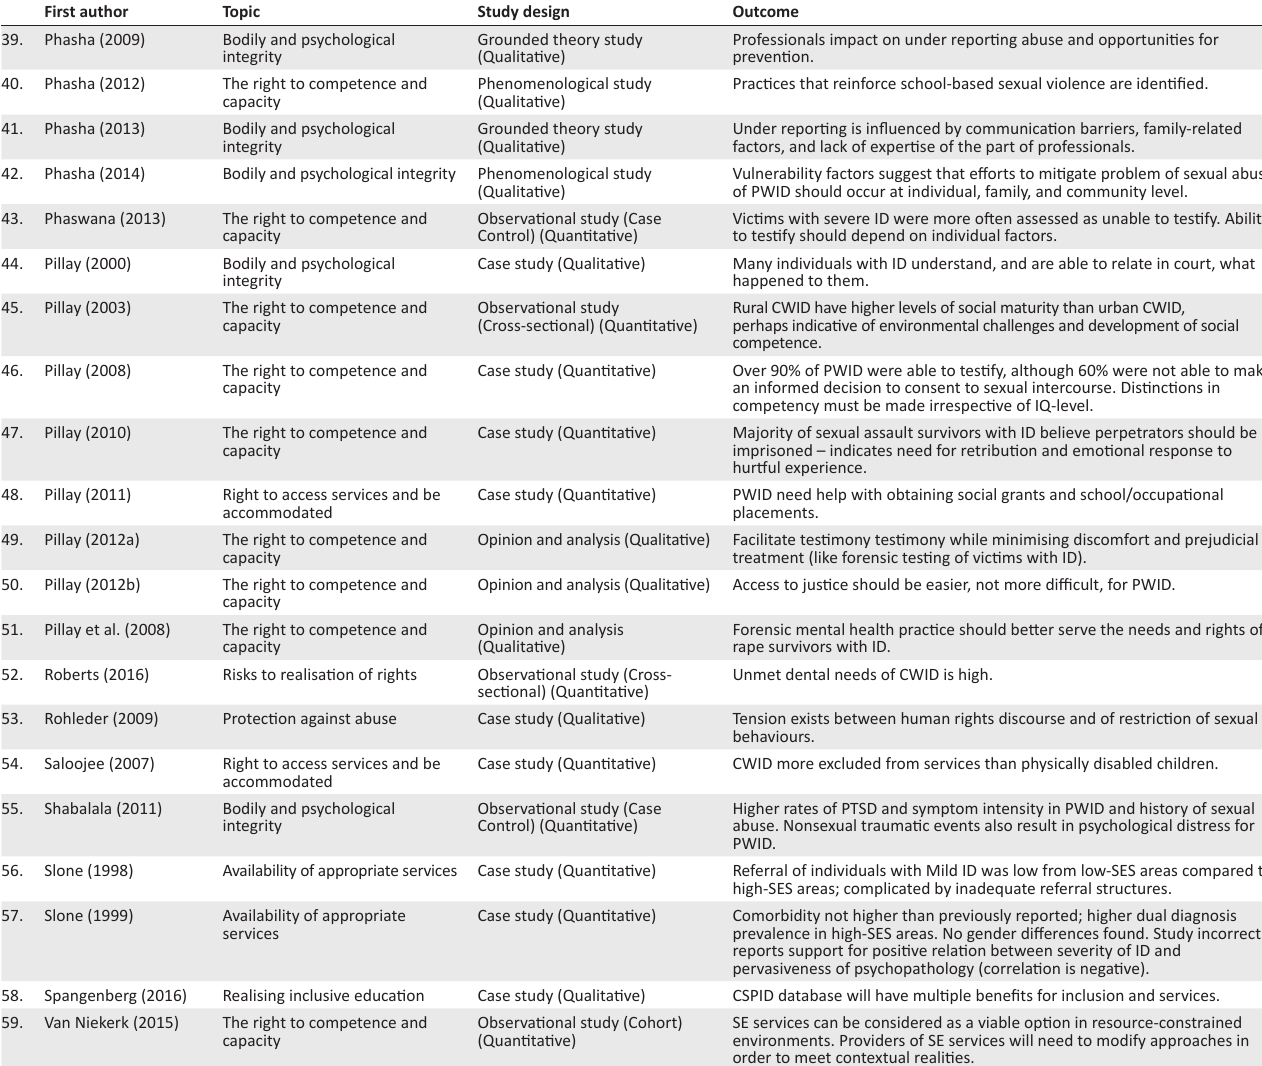
TABLE 4 (Continues...): Characteristics of included studies ( n = 59).